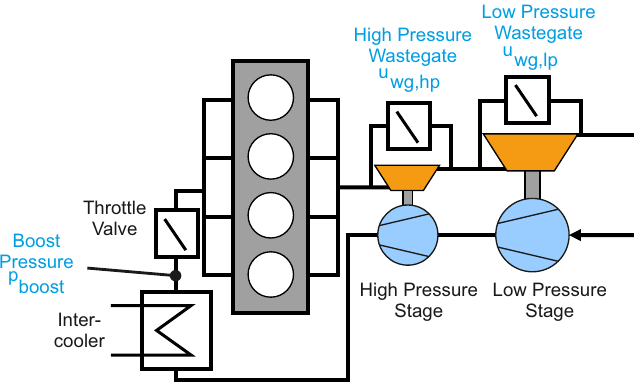
Figure 1. Physical system overview of the investigated two-stage turbocharging